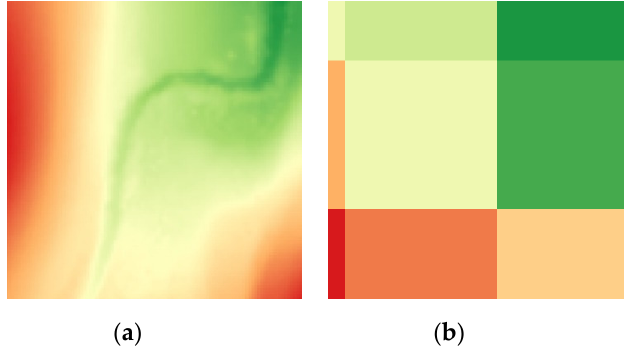
Figure 13. The comparison between high- and low-resolution elevation data: ( a ) LIDAR data (0.5 m pixel size); ( b ) digital terrain elevation data (DTED) 2 data (30 m pixel